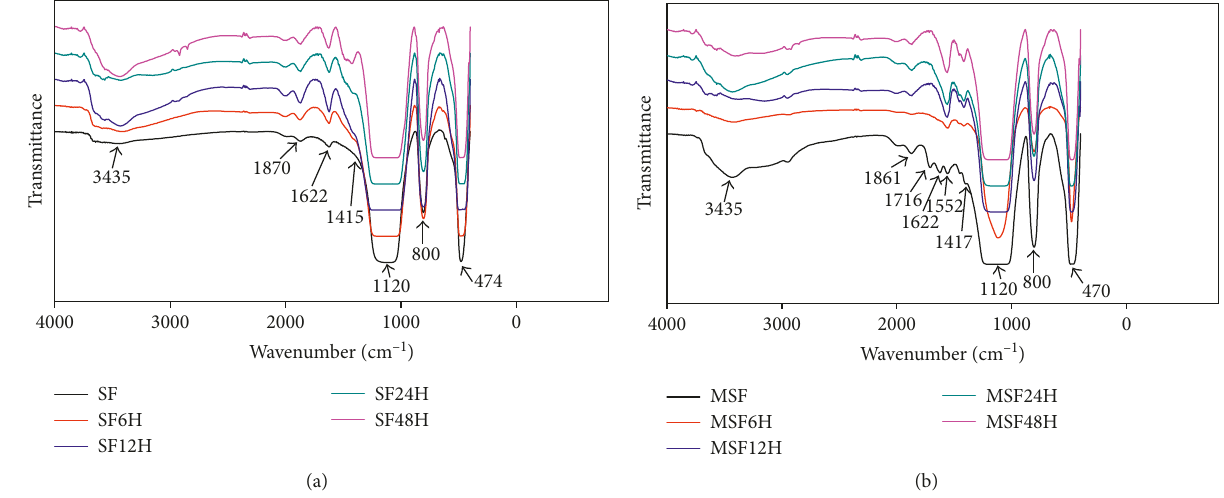
Figure 5: FTIR curves for SF (a) and MSF (b) with different immersed